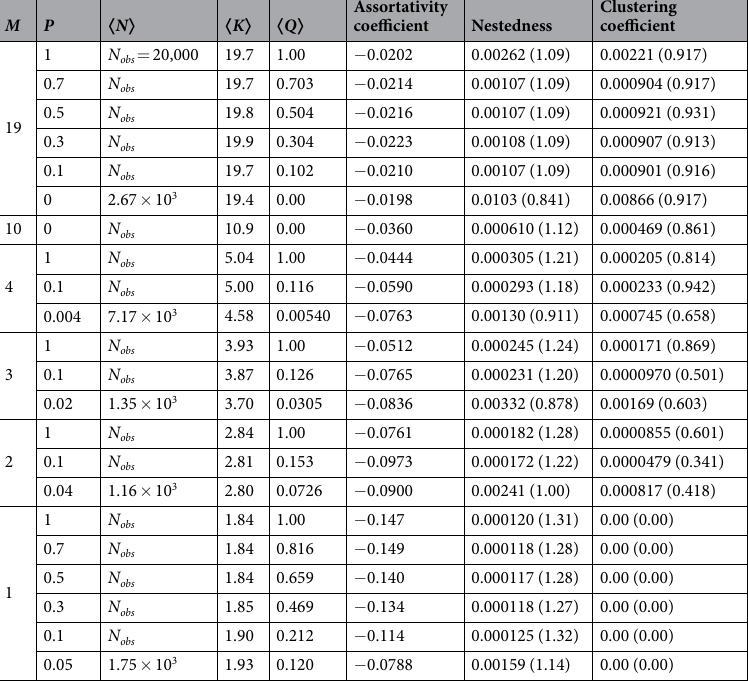
Table 3. Network characteristics of the emergent systems. For the case in the diverging phase, we observe the system when it first reaches a certain size N obs = 20,000. The numbers in the parenthesis for clustering coefficient and nestedness are those ratios to the ones of Erdös-Rényi random graph with the same size and degree, i.e. N = 〈 N 〉 , K = 〈 K 〉 , Q = 〈 Q 〉